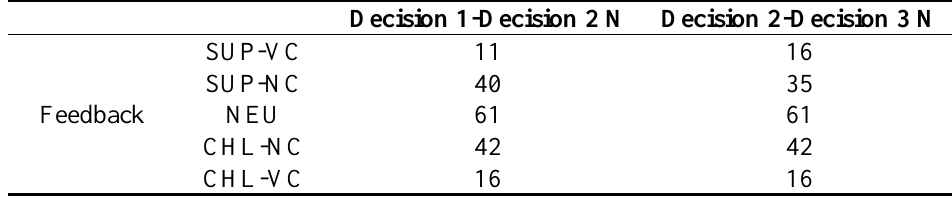
Table 6. Subjects per Feedback Treatment.